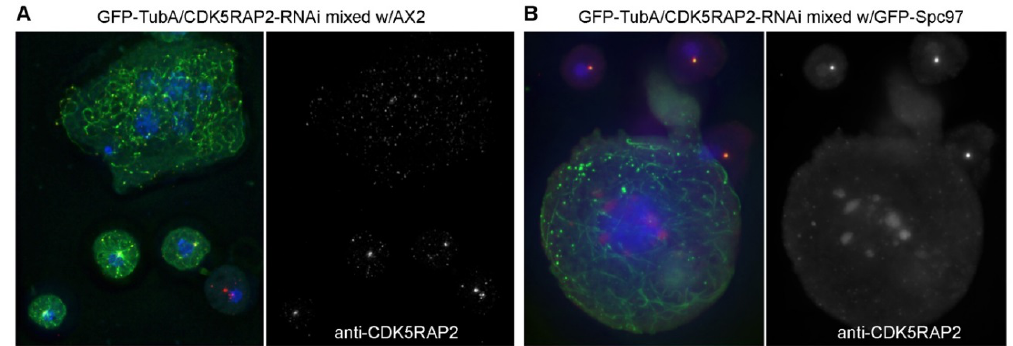
Figure 5. CDK5RAP2RNAi cells contain display disrupted microtubule arrays and enlarged nuclei. Immunofluorescence microscopy of GFP-TubA/CDK5RAP2RNAi cells mixed with AX2 control cells ( A ) or GFP-Spc97 cells ( B ) stained with rabbit anti-CDK5RAP2. DNA-staining with DAPI is shown in